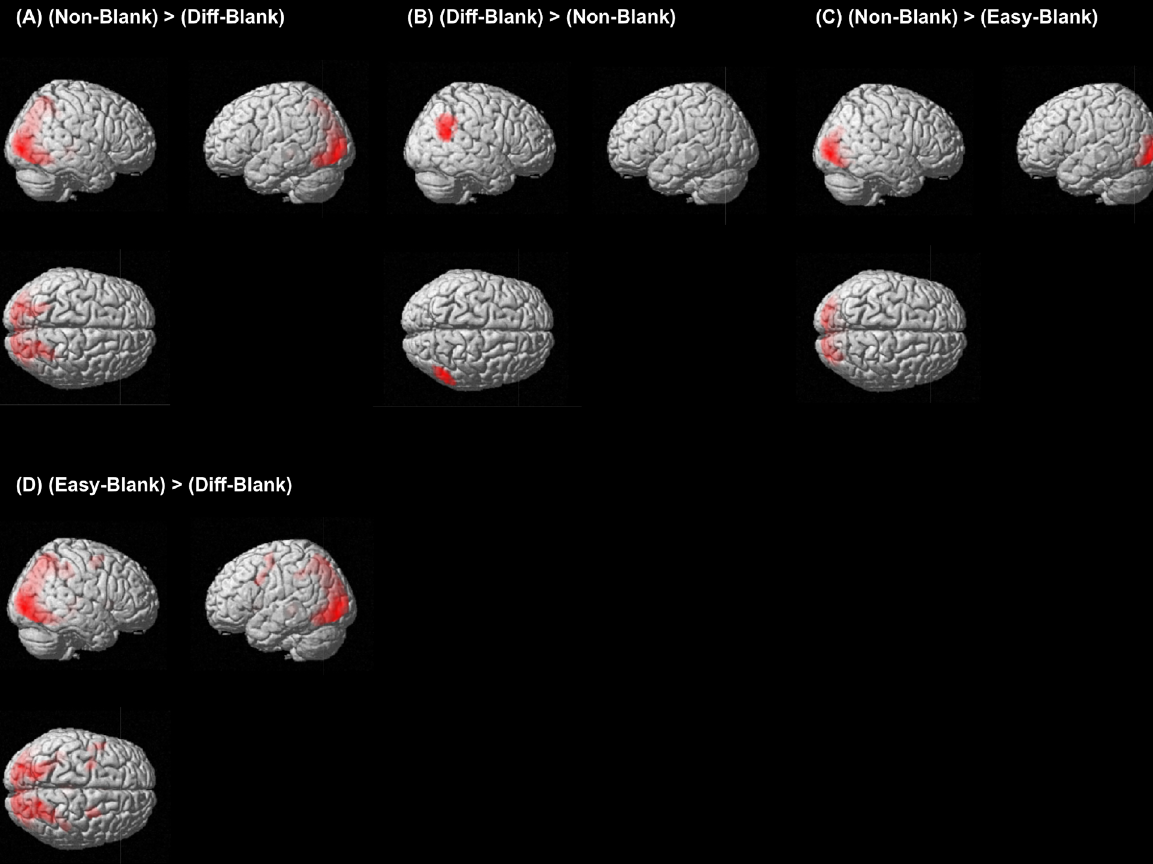
Figure 2. Areas were more activated in Blank-phase (voxel level threshold of p uncorr < 0.001 with cluster level threshold of p FWE − corrected < 0.05 ). ( A ) BOLD signals in these areas were higher in Non-Blank than in Diff- Blank , ( B ) in Diff-Blank than in Non-Blank , ( C ) in Non-Blank than in Easy-Blank , and ( D ) in Easy-Blank than in Diff-Blank